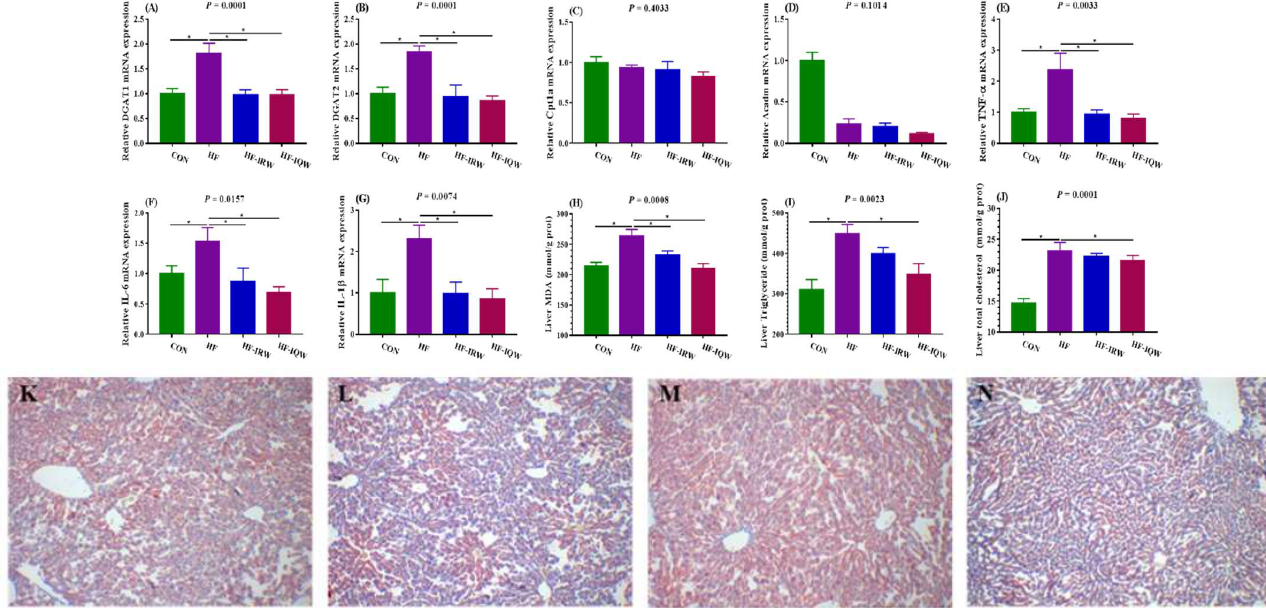
Figure 3. Effects of egg protein transferrin-derived peptides IRW (lle-Arg-Trp) and IQW (lle-Gln-Trp) on lipid deposition and inflammation of the liver of mice fed an HF diet. ( A – G ) mRNA expres- sion of DGAT1 (Diacylglycerol O-Acyltransferase (1), DGAT2 (Diacylglycerol O-Acyltransferase (2), Cpt1a (carnitine palmitoyltransferase 1A), Acadm (acyl-CoA dehydrogenase medium chain), TNF- α, IL-6, and IL-1β. ( H – J ) MDA, triglyceride, and total cholesterol levels. ( K – N ) Oil red O staining (microscope’s magnification= 100 times) of the CON, HF, HF-IRW, and HF-IQW groups. MDA: malondialdehyde. * indicates p < 0.05 between the HF group and other groups.